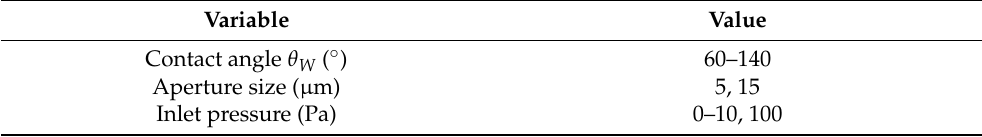
Table 1. Table of the experimental